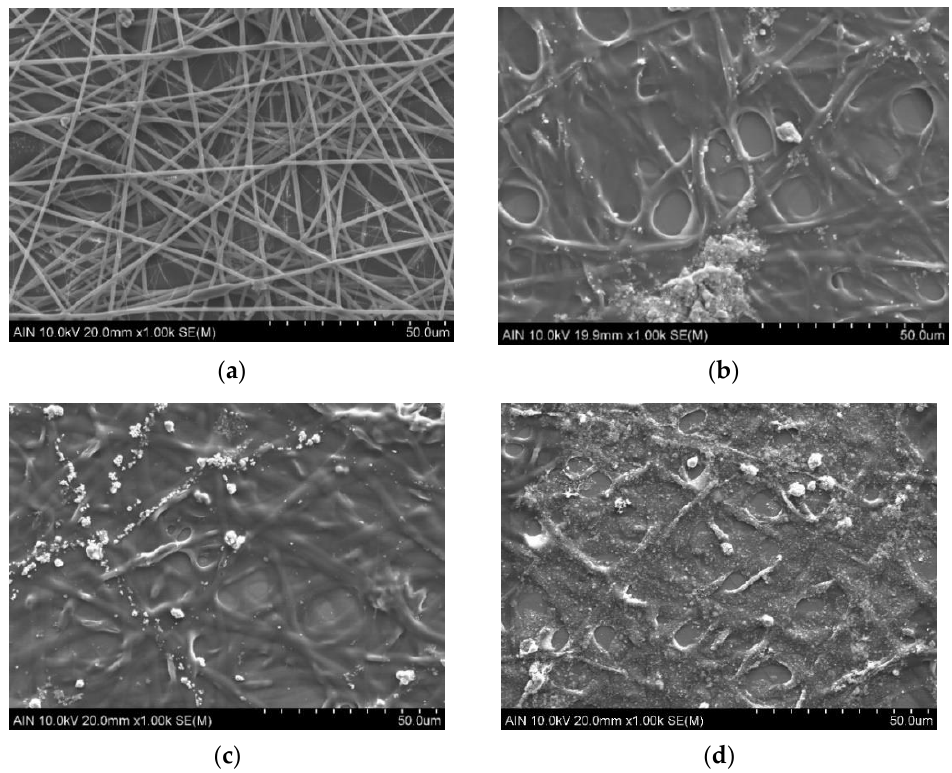
Figure 5. SEM images of the four analyzed samples: ( a ) PAA + β -CD; ( b ) PAA + β -CD//TiO 2 /PAA; ( c ) PAA + β -CD//TiO 2 /PAA + WO 3 ; ( d ) PAA + β -CD//TiO 2 /PAA + Fe 2 O 3 .